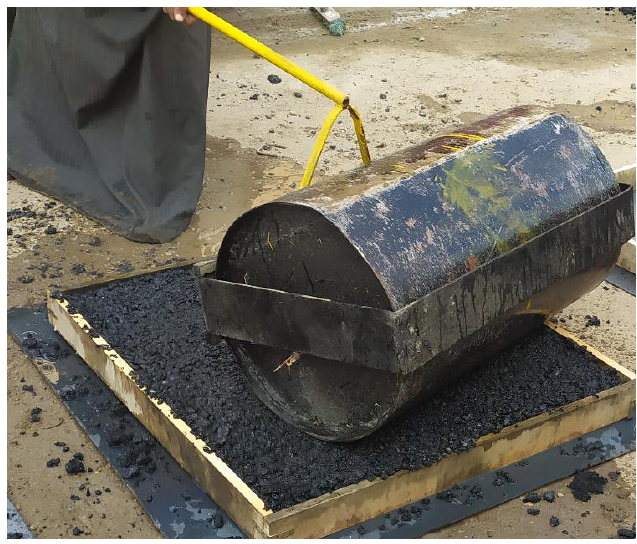
Figure 3. Roller compactor.